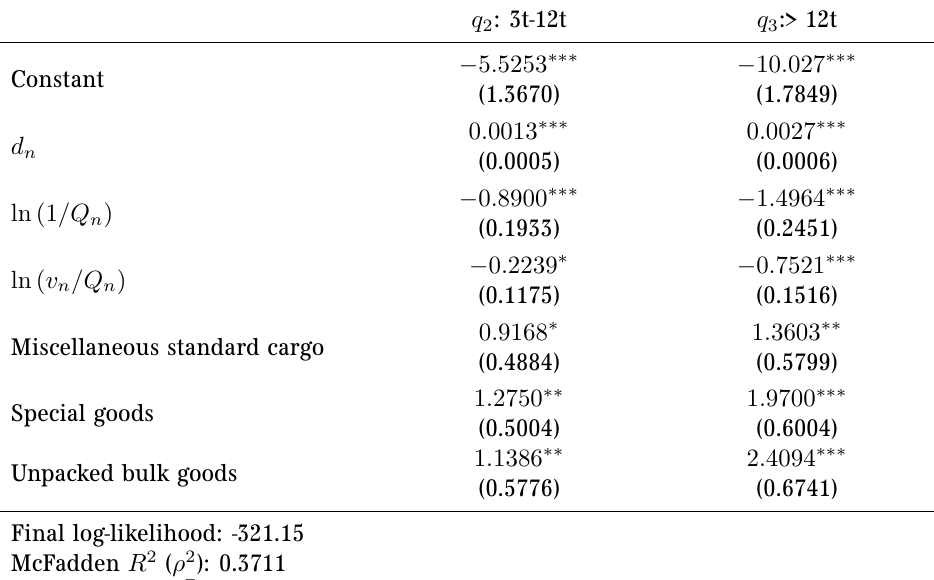
Table 12: Results of the discrete shipment size choice model presented by Piendl et al. (2017). q 2 : 3t-12t q 3 :>